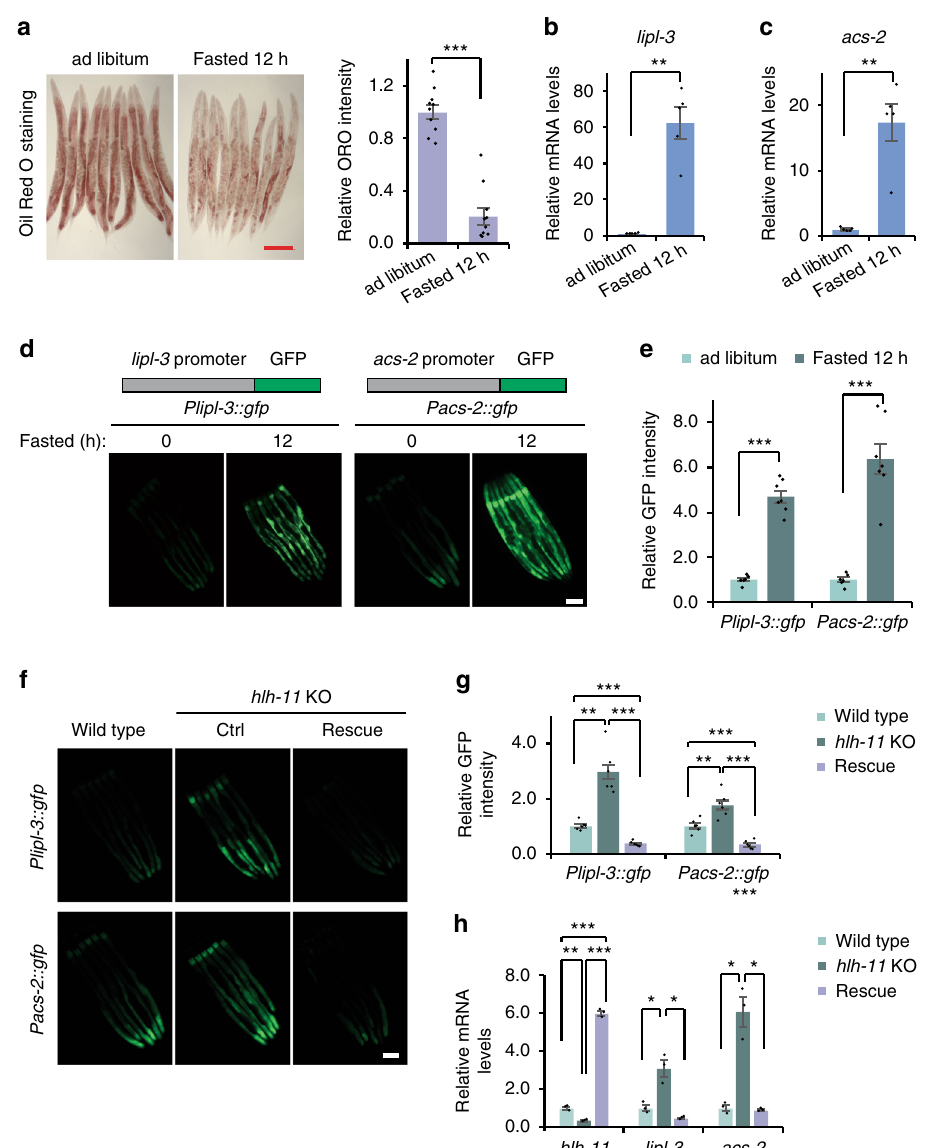
Fig. 1 HLH-11 regulates the transcription of starvation response genes. a Oil Red O staining and quanti fi cation of wild-type worms (day 1 adult) fed ad libitum or fasted for 12 h. n = 10 worms examined per condition. Data shown here are from one experiment. Four independent experiments were performed with similar results. Scale bar, 200 μ m. *** p = 2.7E − 08. b , c qPCR analyses of endogenous mRNA levels of lipl-3 ( b ) or acs-2 ( c ) in wild-type worms fed ad libitum or fasted for 12 h. ** p = 0.0020 ( b ), **p = 0.0043 ( c ). n = 5 biologically independent samples. d Fluorescence images of Plipl-3::gfp and Pacs-2::gfp worms fed ad libitum or fasted for 12 h. Four independent experiments were performed with similar results. Scale bar, 100 μ m. e Quanti fi cation of GFP intensity in d . n = 6 – 7 worms examined. *** p = 3.6E − 6 (left), 0.00018 (right). f Fluorescence images of Plipl-3::gfp and Pacs-2::gfp reporters in wild-type or hlh-11 knockout (KO) worms or hlh-11 knockout worms with exogenous expression of HLH-11 (rescue). Four independent experiments were performed with similar results. Scale bar, 100 μ m. g Quanti fi cation of GFP intensity in f . n = 6 worms examined. The exact p values are provided in the Source data. h qPCR analyses of endogenous mRNA levels of hlh-11 , lipl-3 or acs-2 in wild-type, hlh-11 KO, or hlh-11 rescue worms. n = 3 biologically independent samples. The exact p values are provided in the Source data. Error bars indicate mean ± SEM. Statistical analyses were performed by Student ’ s t test (unpaired, two tailed), * p < 0.05; ** p < 0.01; *** p < 0.001. Source data are provided as a Source data fi of DNA in the second exon of hlh-11 was replaced by 17 bp (Supplementary Fig. 1e), resulting in a frameshift that abolishes the function of HLH-11. Consistent with the RNAi results, GFP signals were elevated in hlh-11 KO animals expressing the Plipl-3:: gfp and Pacs-2::gfp reporters (Fig. 1f, g). In addition, we generated an extrachromosomal strain that expresses wild-type hlh-11 under its own promoter and introduced it into hlh-11 KO animals. Complementing HLH-11 function was suf fi cient to suppress GFP reporter induction in hlh-11 KO worms (Fig. 1f, g).